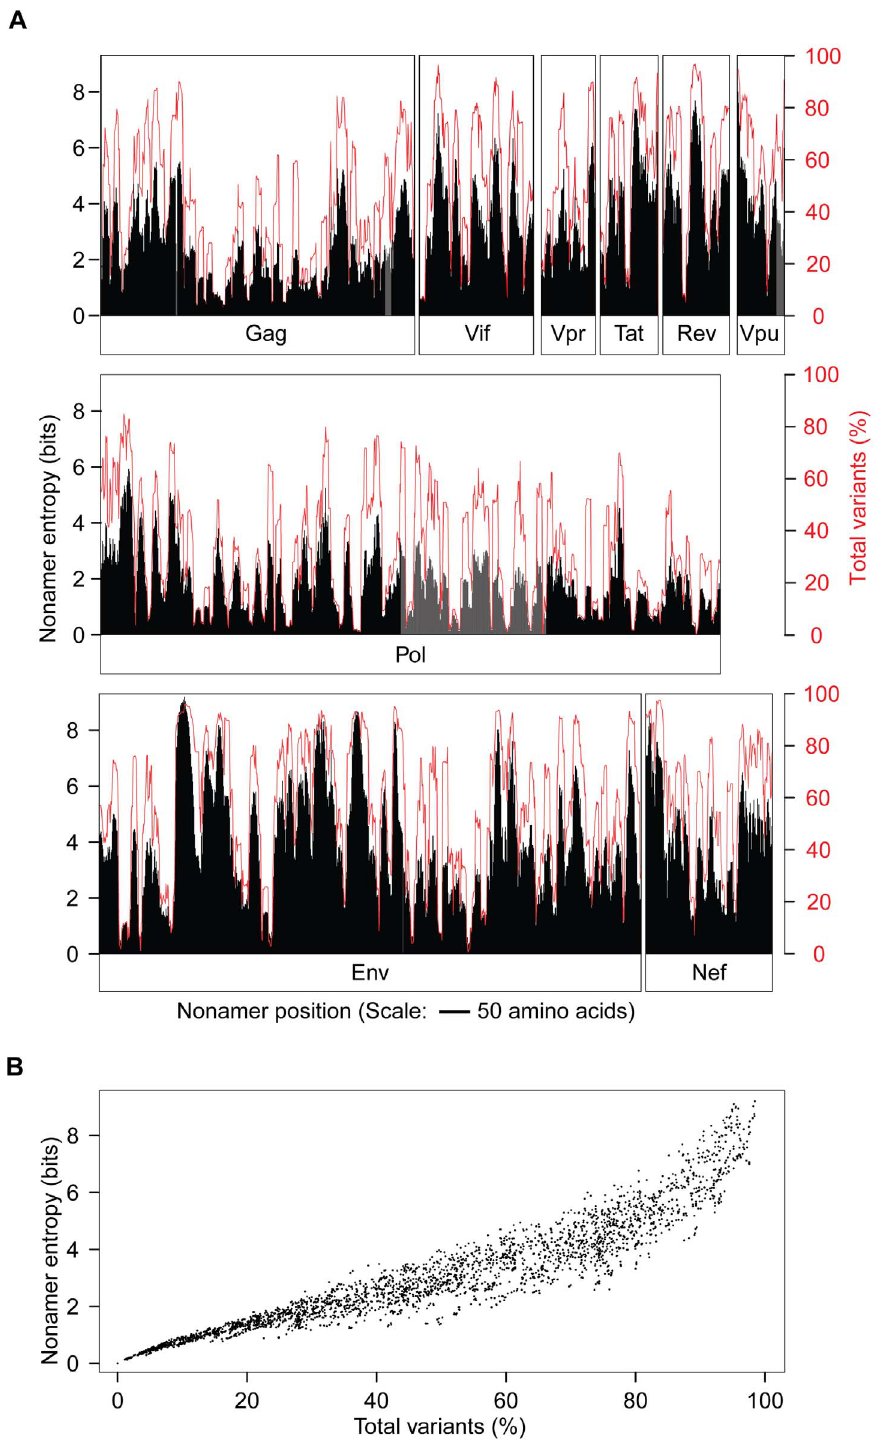
Figure 2. HIV-1 clade B proteome nonamer sequence entropy and total variants. A. Entropy (in black) and incidence of the total variants of the index (in red) was measured for each aligned nonamer (nine amino acids) position (1–9, 2–10, etc. ) of the proteins. The entropy values indicate the level of variability at the corresponding nonamer positions, with zero representing completely conserved sites (0% total variants incidence), with a maximum of about 9 at the extremely variant sites ( , 98% total variants incidence). B. Relationship of entropy and the incidence of total variants for the proteome nonamer positions.